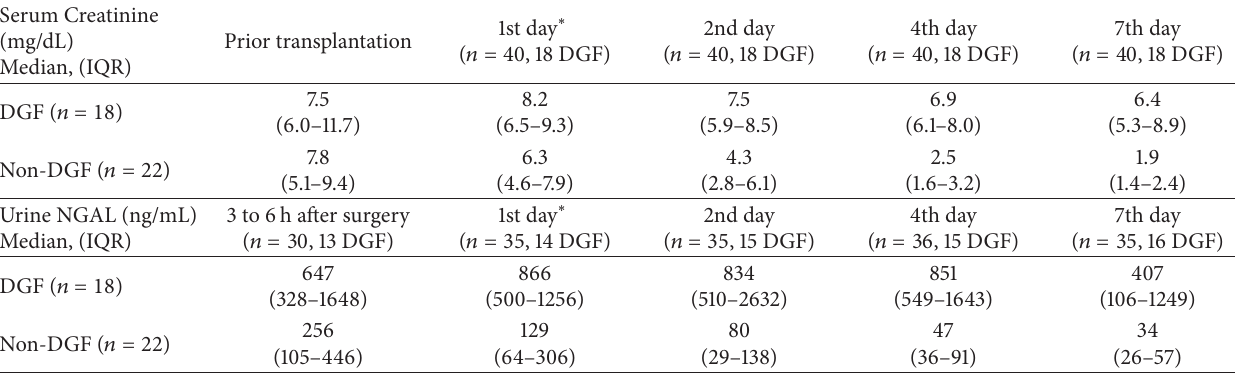
Table 2: Serial levels of serum creatinine and uNGAL through the first posttransplant week, according to graft function (delayed or prompt). Serum Creatinine